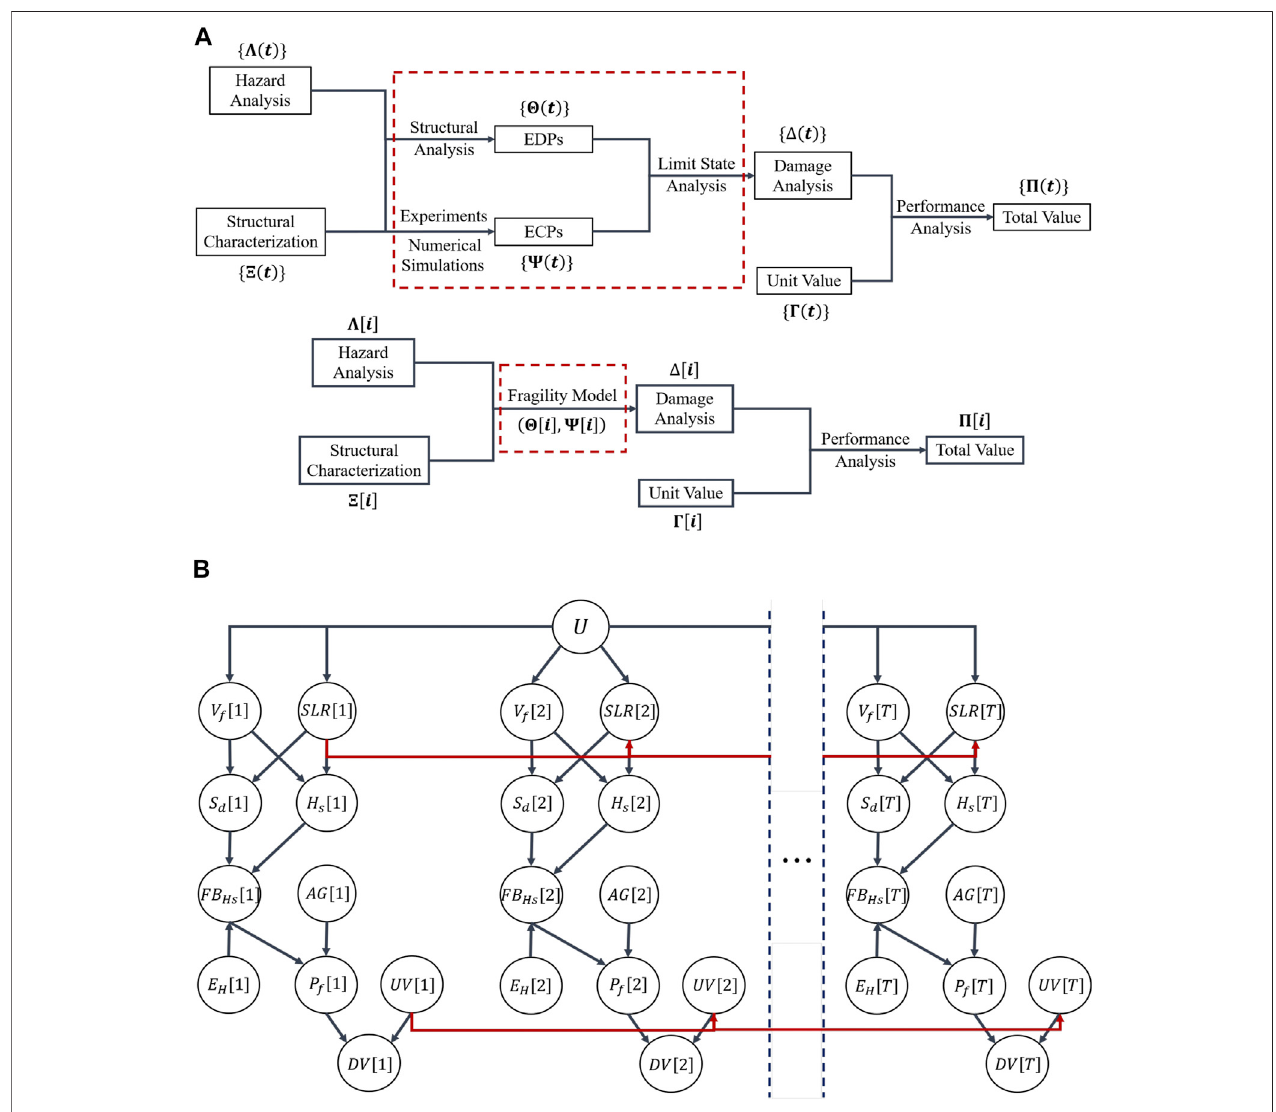
FIGURE 3 | (A) Performance-Based Coastal Engineering framework representation of a typical Gulf Coast elevated residential structure subjected to storm surge and waveloading, de fi ned both ascontinuousand discrete(i.e., at atimeindex [ i ] ) in time (B) DBN model of atypical GulfCoast elevated residential structure subjected to storm surge and wave